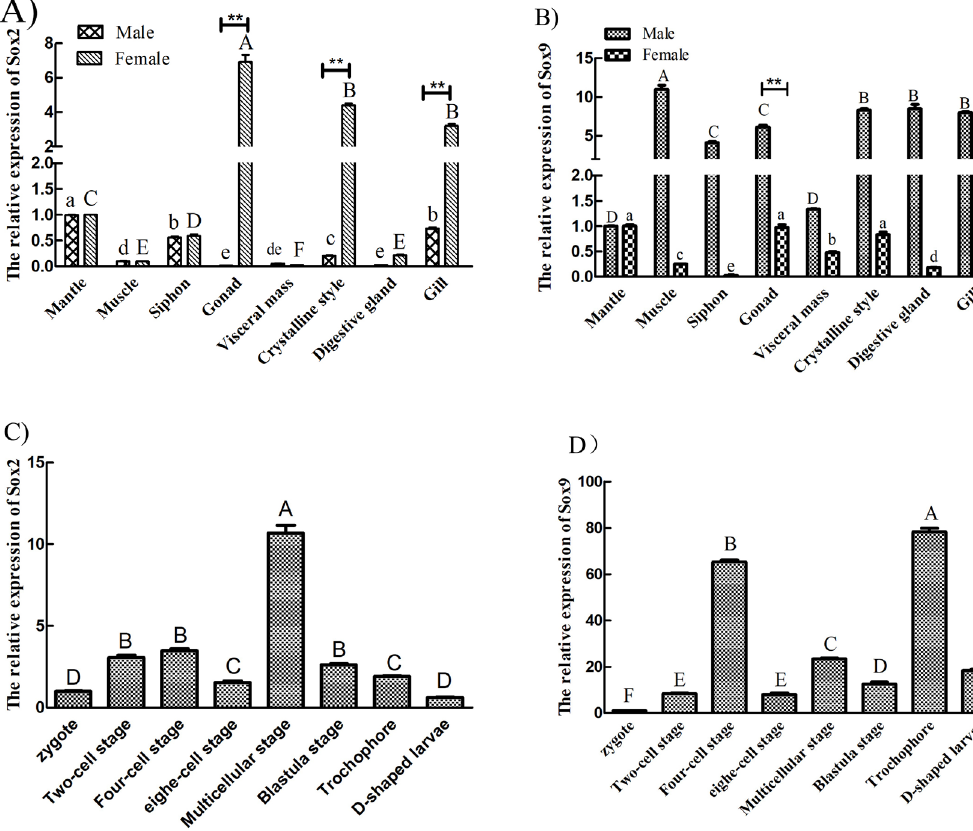
Figure 5. Relative expression of LsSox2 and LsSox9 in tissues of Lutraria sieboldii . ( A ) LsSox2 and ( B ) LsSox9 . Expression of LsSox2 and LsSox9 at different stages of development . ( C ) LsSox2 and ( D ) LsSox9 . Each bar represented mean ± SEM (n = 3), asterisks above the bars indicate the results of Duncan’s test at ** p < 0.01; Different letters indicate a significant difference.